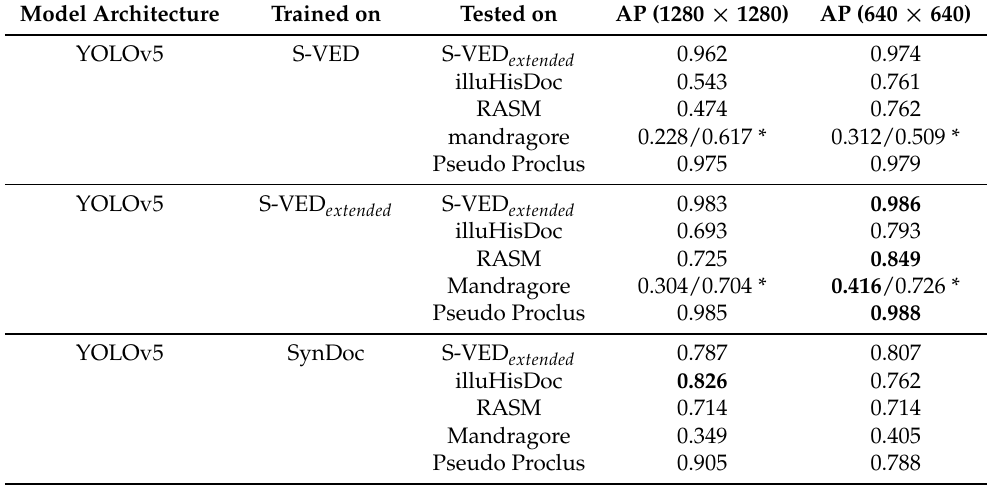
Table 4. Performance of YOLOv5 trained on S-VED, S-VED extended , and SynDoc respectively with respect to the different historical document datasets (* marks results where recognized Initials are ignored).